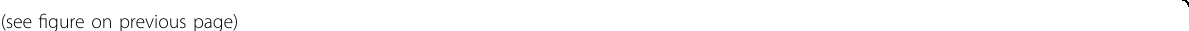
Fig. 2 The putative cleavage site in MRE11 lies within a 22 amino acid region, namely amino acids 559 – 580. A A map of the lentiviral vector including either intact MRE11 or MRE11 with the initial putative cleavage site (PCS) at amino acids 539 – 600 removed. The functional domains of MRE11 are indicated 50,51 . B Schematic representation of MRE11 with the various mutants, including complete deletion of the region (MRE11 PCS removed) and sequential deletions of 12 amino acids (MRE11 Δ 539 – 550, Δ 549 – 560, Δ 559 – 570, Δ 569 – 580, Δ 579 – 590 and Δ 589 – 600). C The MRE11 mutant lacking the initial putative cleavage site failed to generate truncated MRE11. D MRE11 mutants lacking either 559 – 570 or 569 – 580 aa did not generate the approximately 20 kDa size short form of cleaved MRE11 in RT112 cells, as seen using anti-myc-tag and anti-MRE11 ab 30725 antibodies. E pLenti-TR-MRE11 vector was designed by deleting 569 – 708 aa from FL-MRE11 (amino acids deleted shown in upper panel). Lower panel shows the truncation in diagrammatic